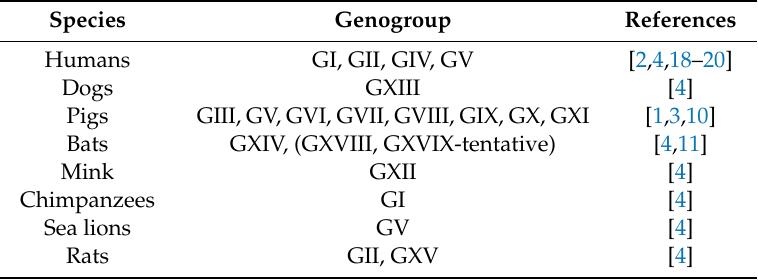
Table 1. Distribution of sapovirus genogroups by